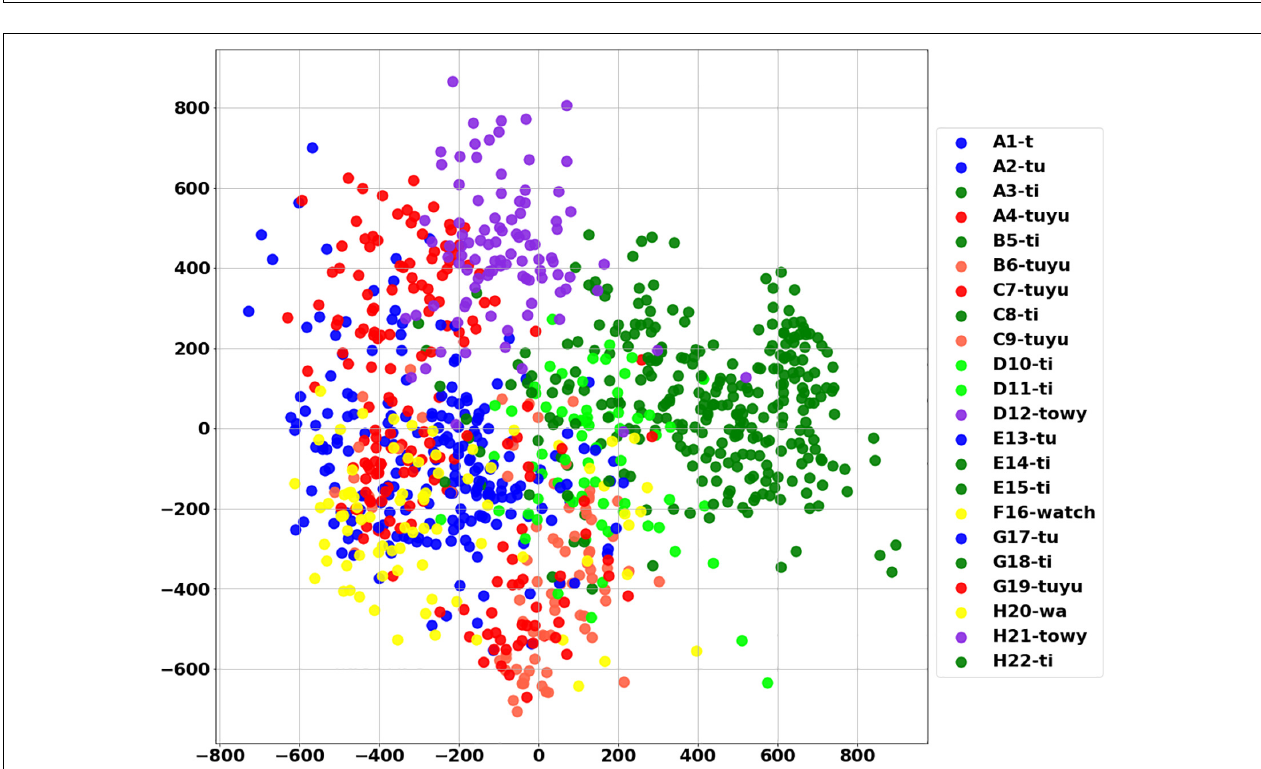
FIGURE 9 | Visualization of syllables using PCA. Explained variance ratio (first two components): (0.43169461